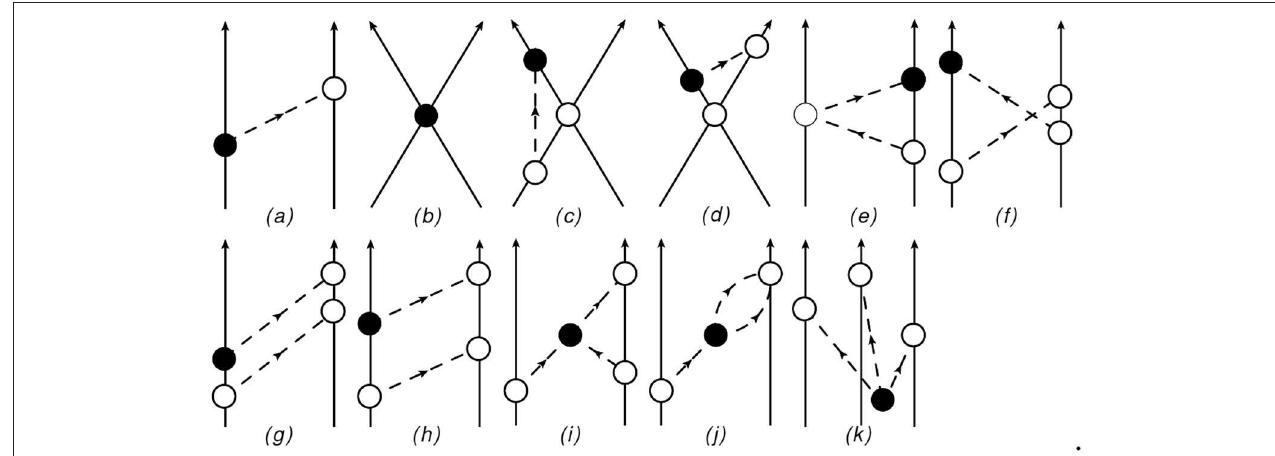
FIGURE 4 | Time-ordered diagrams contributing to the PVTV potential (only a single time ordering is shown). Nucleons and pions are denoted by solid and dashed lines, respectively. The open (solid) circle represents a PCTC (PVTV) vertex.